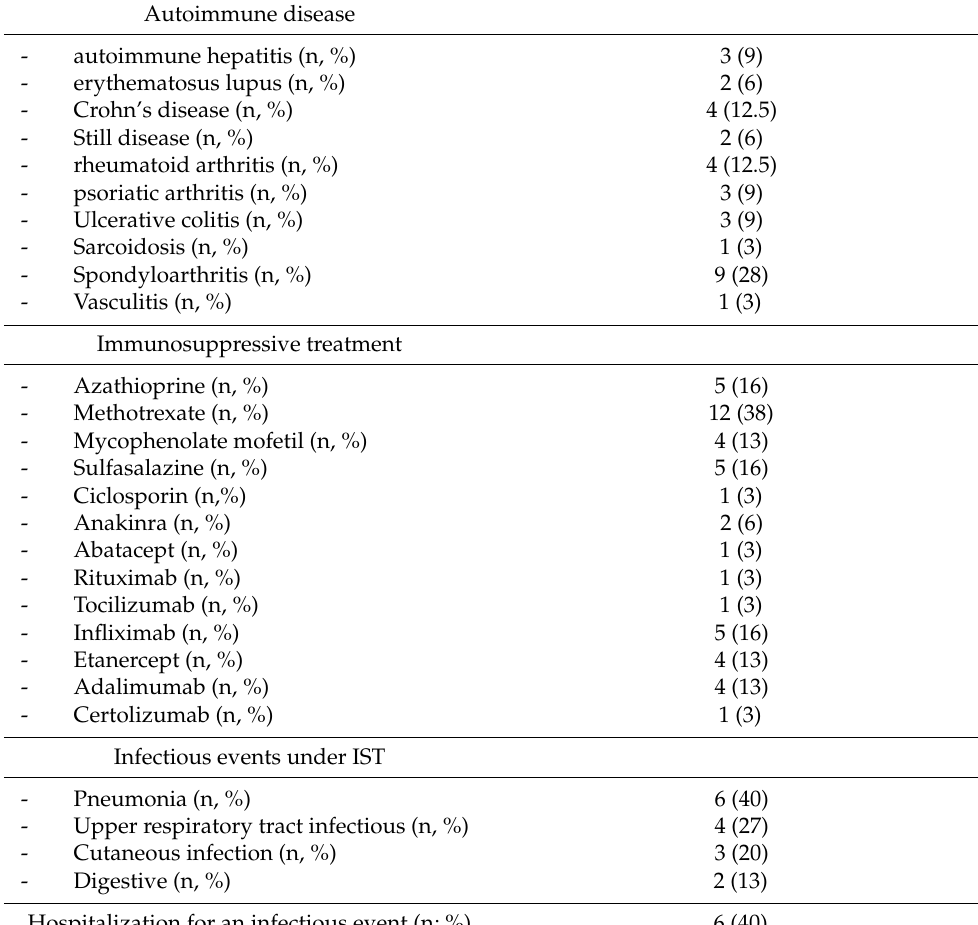
Table 2. Description of patient auto-immune disease, immunosuppressive treatment and